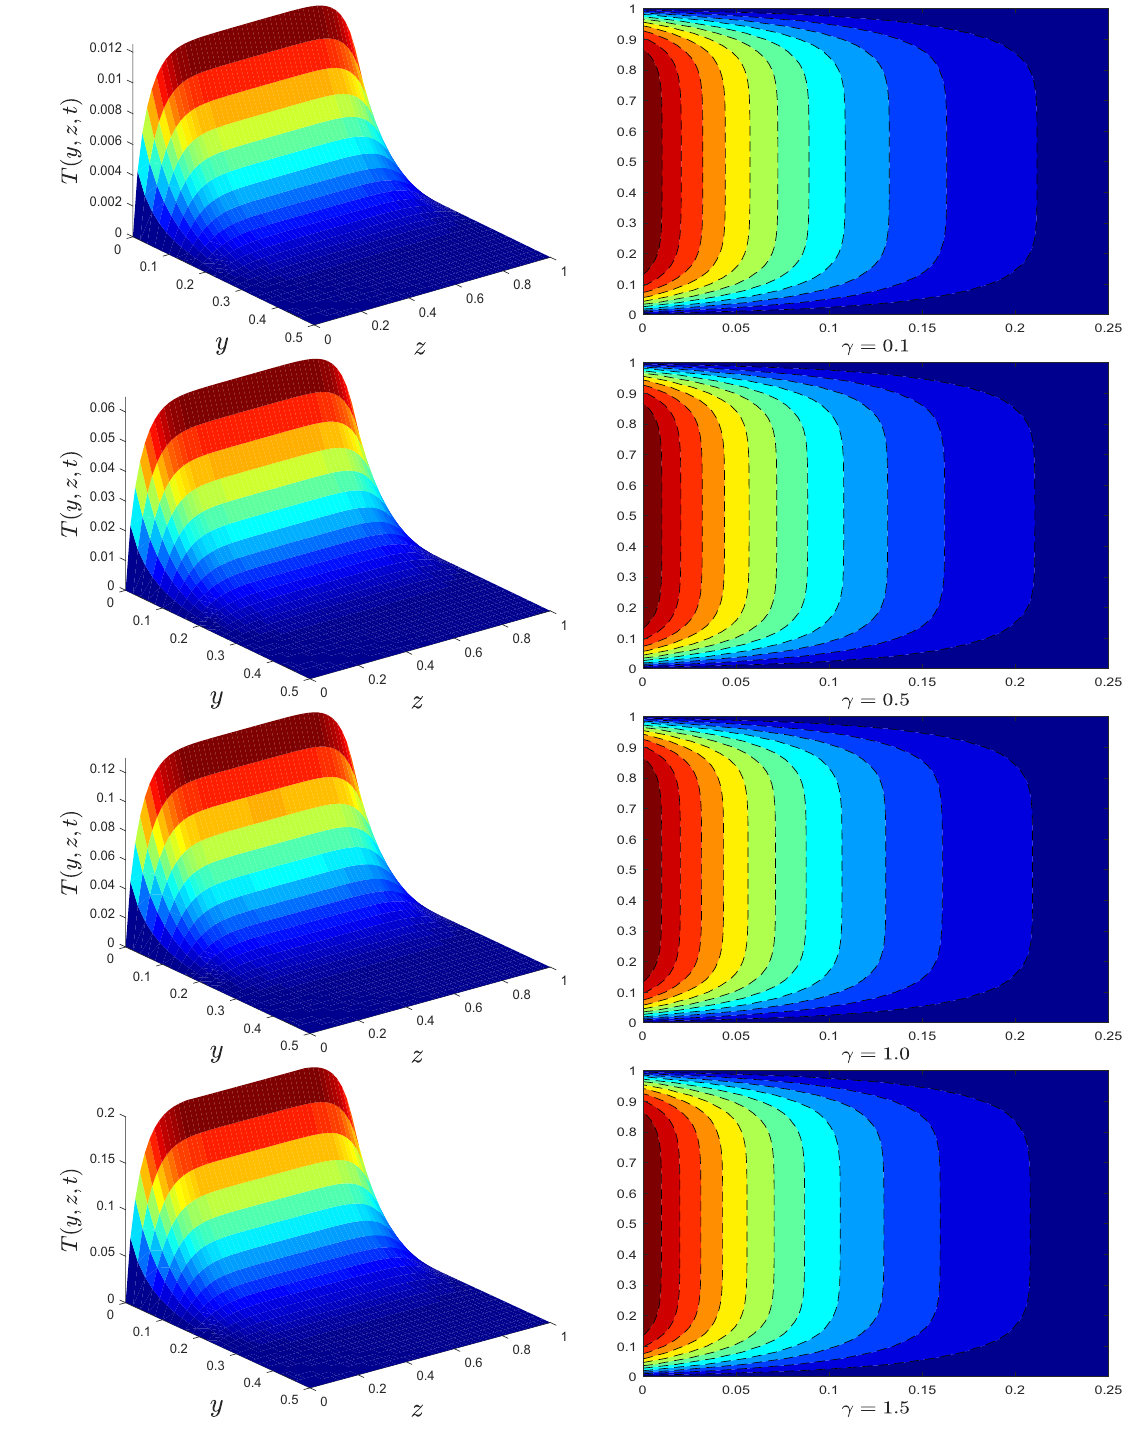
Figure 6. Temperature profile for different values of conjugate heat transfer parameter γ